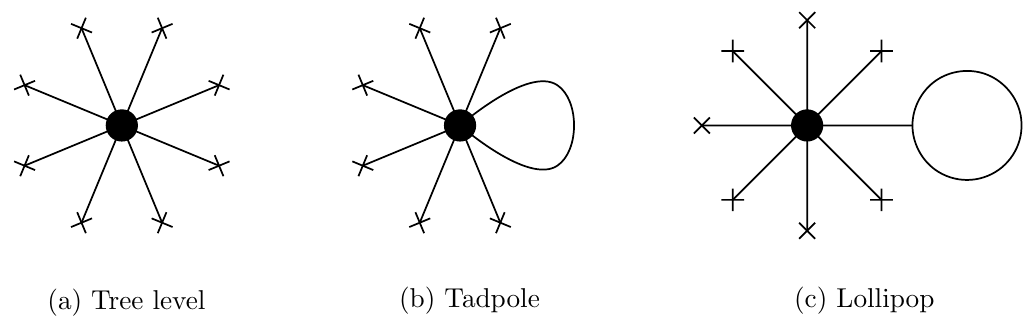
Figure 2 . Diagrams that contribute at tree level (a) and one-loop order (b)-(c) to a single-trace operator such as h tr Z L i L =8 (in the planar limit). The black dot denotes the operator and the crosses signify the insertion of the classical